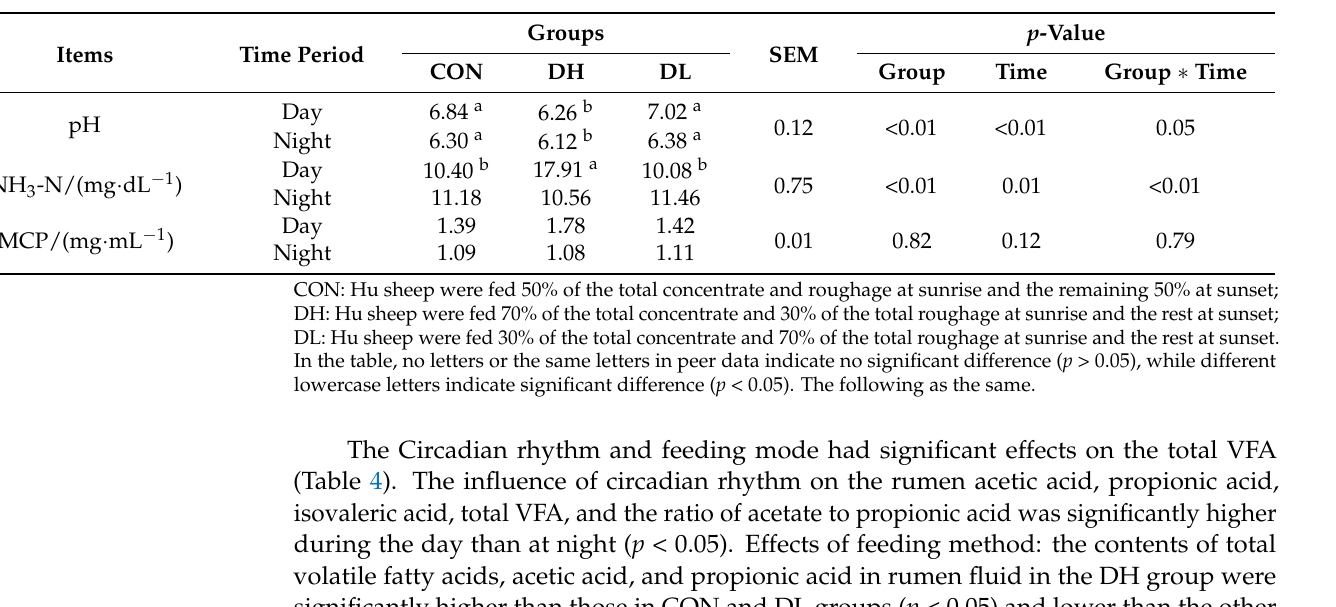
Table 3. Correlation among circadian rhythm and rumen pH, NH 3 -N, and MCP in HU Sheep.